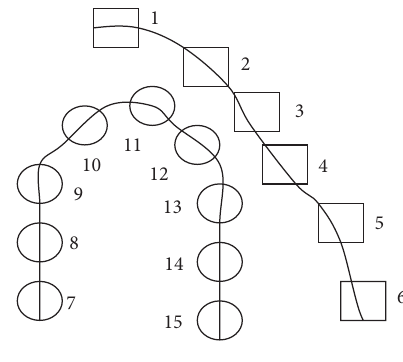
Figure 1: The short-circuit problem. Table 1: Comparison of four dimensionality reduction methods for iris dataset